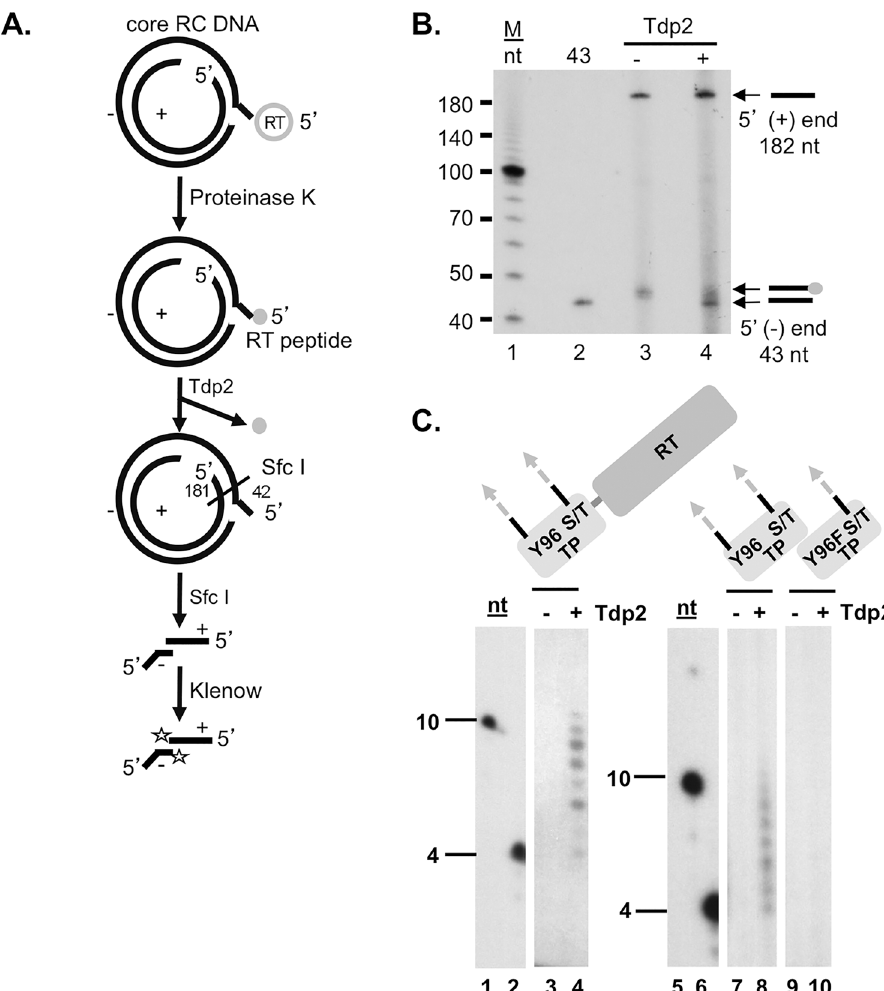
Fig 1. Tdp2 cleavage of the covalent linkage between the RT protein and the 5 ’ end of the viral minus strand DNA. (A) and (B). Tdp2 removal of proteinase K-derived RT peptide from the 5 ’ end of core RC DNA. (A) Diagram of the Tdp2 cleavage reaction and detection of the cleavage product derived from the HBV RC DNA. HBV DNA extracted from cytoplasmic nucleocapsids (core) with proteinase K digestion was